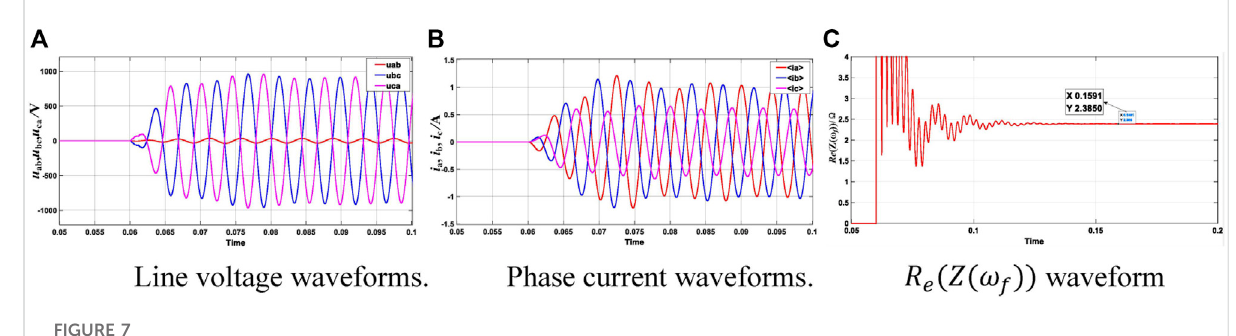
FIGURE 7 Permanent two-phase short circuit fault at end of